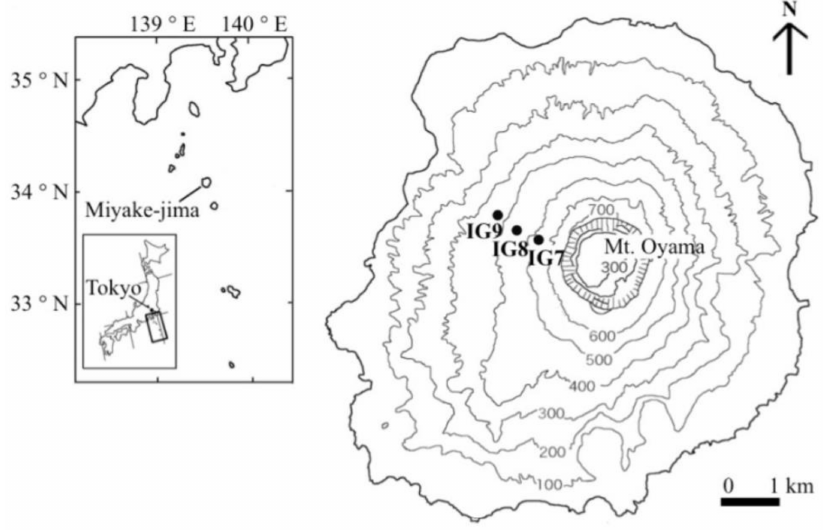
Figure 1. Location of the study sites on Miyake-jima